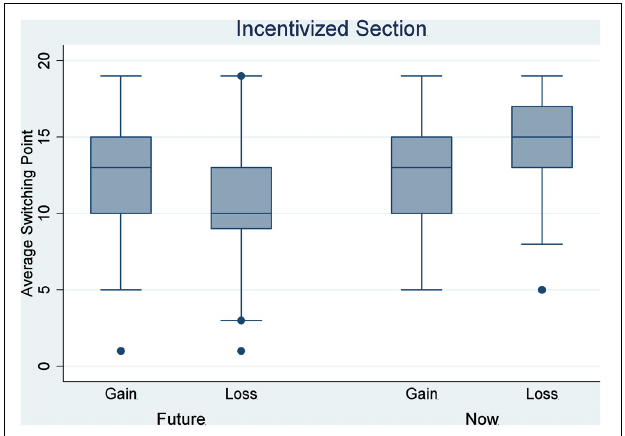
FIGURE 4 | Average switch point by treatment: the incentivized decision